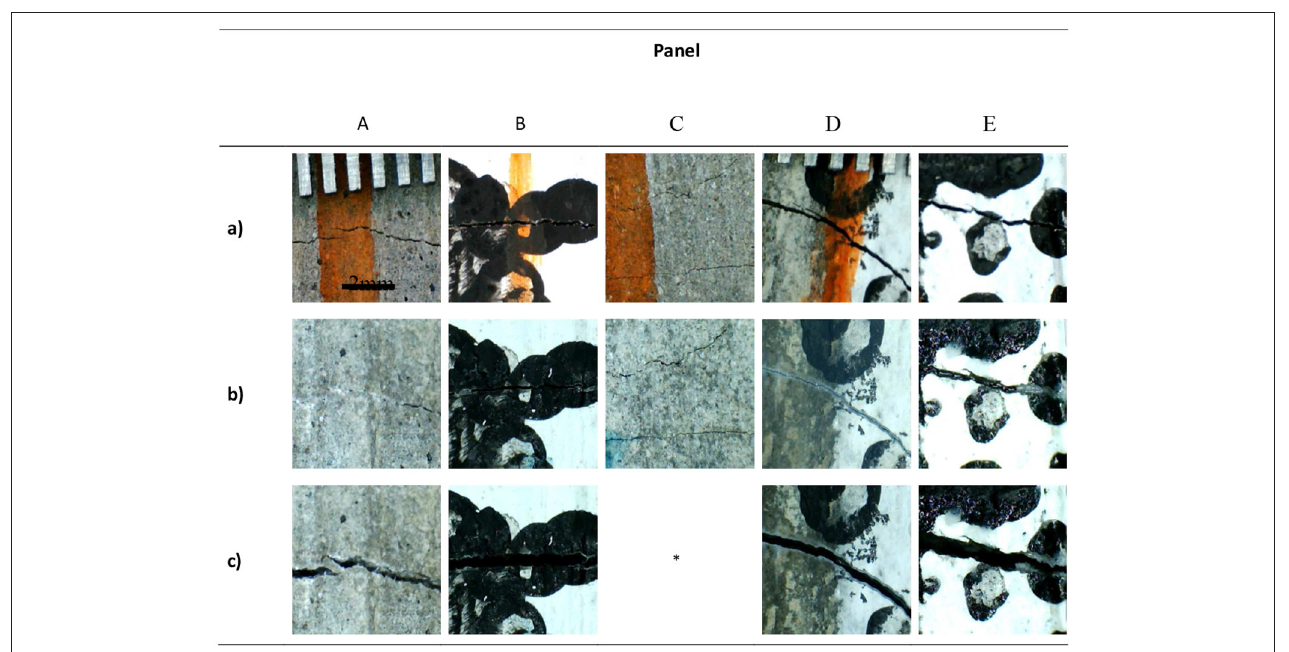
FIGURE 15 | Selected microscope images of cracks after (a) initial loading, (b) 6 months, and (c) final loading. (* Panel not loaded after 6